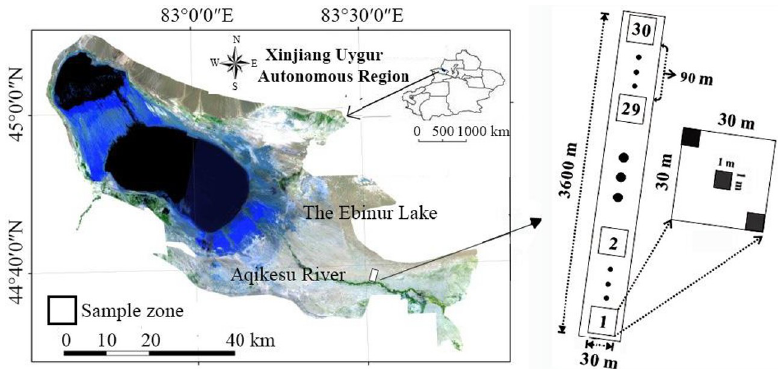
Fig 1. The study area and setup of the sample plots. Autonomous Region is downloaded from The Gateway to Astronaut Photography of Earth website (https://eol.jsc.nasa.gov/SearchPhotos/). Because the map downloaded from this website is free and open to scholars, our study does not need to supply a copyright